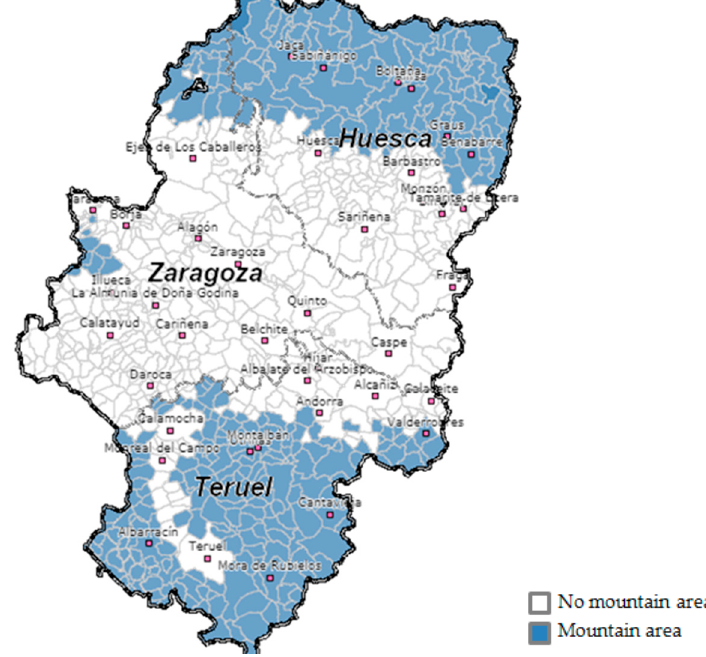
Figure 1. Map of mountain areas in Aragon. Source: Government of Aragon [10].